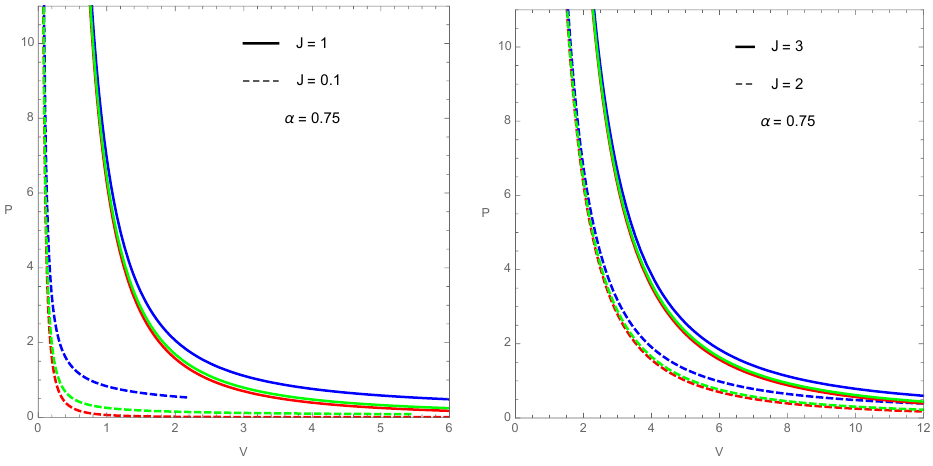
Figure 3 . PV diagram for (cid:11) = 0 : 75, (cid:13) = 0 : 25, J = 0 : 1 ; 1 ; 2 ; 3, and T = 0 : 001 (red), T = 0 : 5 (green), T = 2 (blue). In the (cid:12)rst panel it is possible to see where the solution that satis(cid:12)es eq. (2.16) ceases to exist.